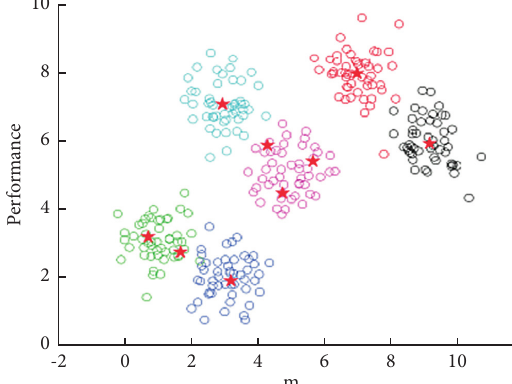
Figure 8: Performance of the test using C-FCM on data set.